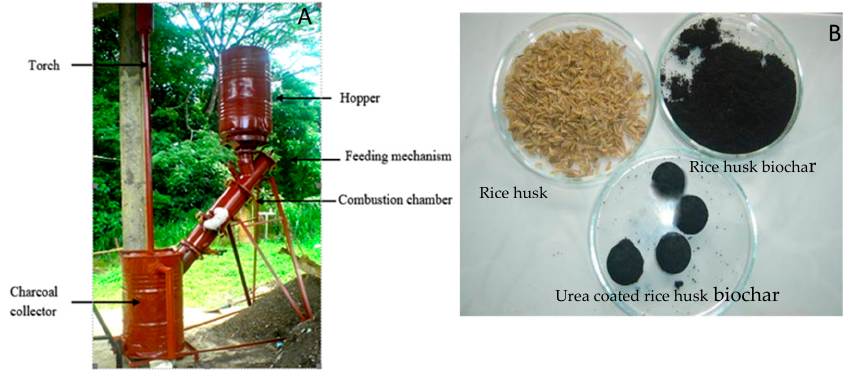
Figure 6. The material used for the biochar production and urea coated biochar generated. A. Pyrolizer; B. Slow releasing nitrogen fertilizer prepared using biochar .